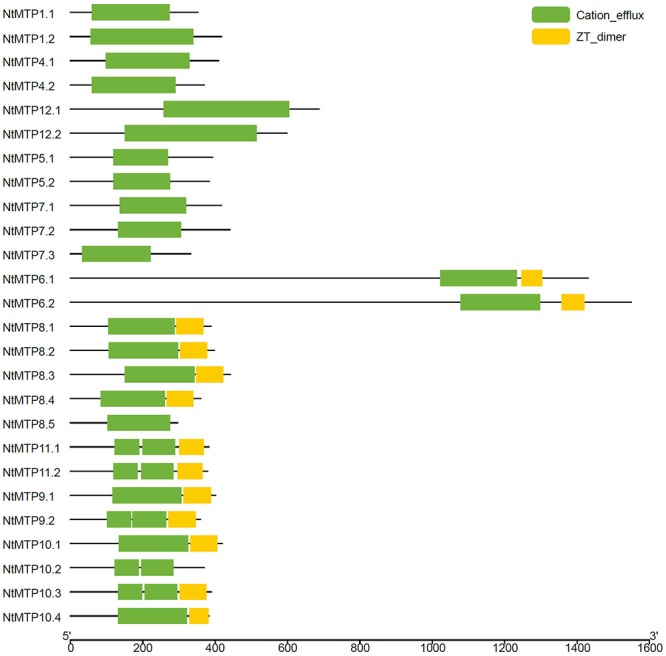
Distributions of the conserved domains in NtMTP proteins. Green boxes indicate cation_efflux domains; yellow boxes indicate ZT_dimers.